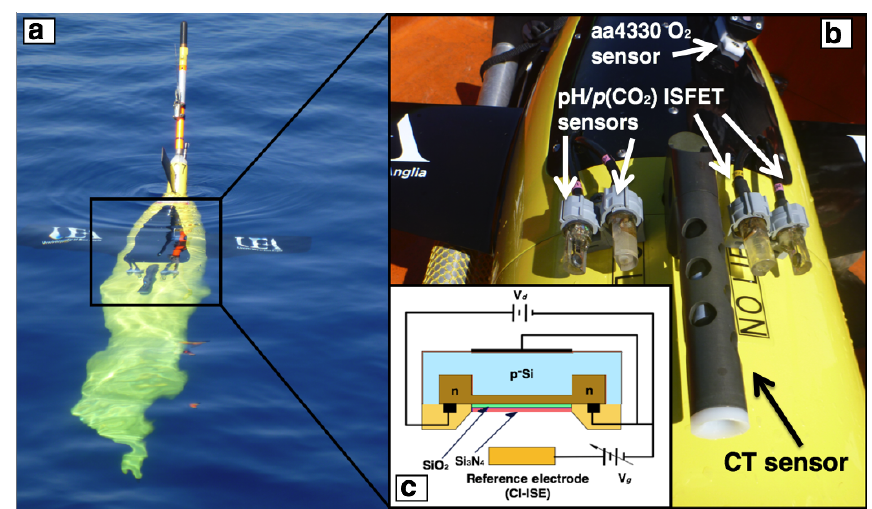
Figure 2. (a) Seaglider SN 537 during the deployment: (b) a close-up of the sensors and (c) a schematic diagram of the ISFET sensor adapted from Shitashima